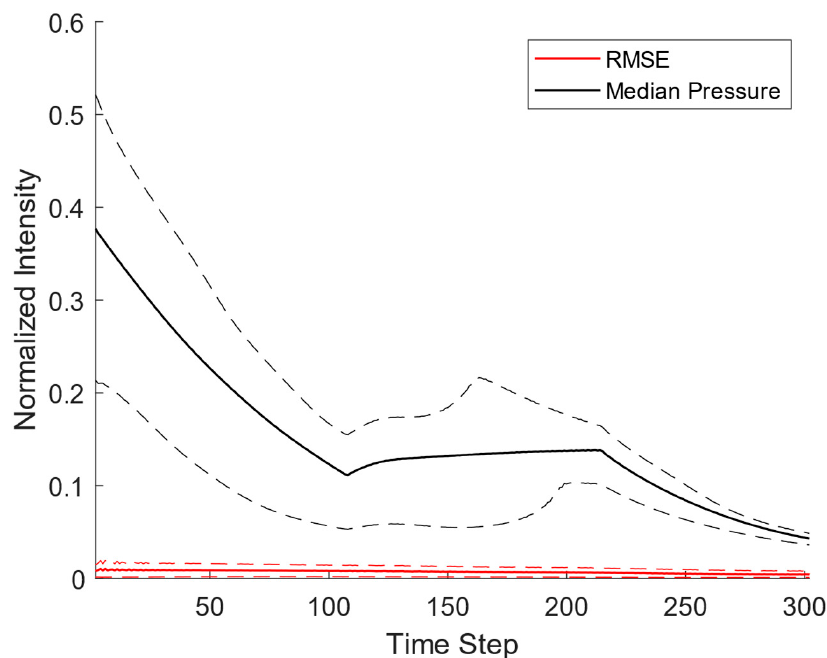
Figure 9. RMSE and standard deviation bands between the k-Wave and FNO forward simulations on the AWA2 test dataset. Distribution of pressures (25th, 50th and 75th percentiles) are provided as a frame of reference.